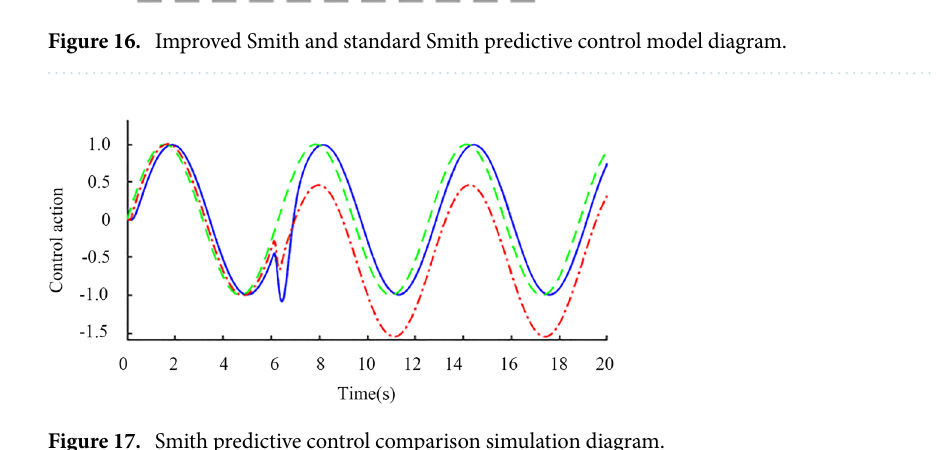
Figure 17. Smith predictive control comparison simulation